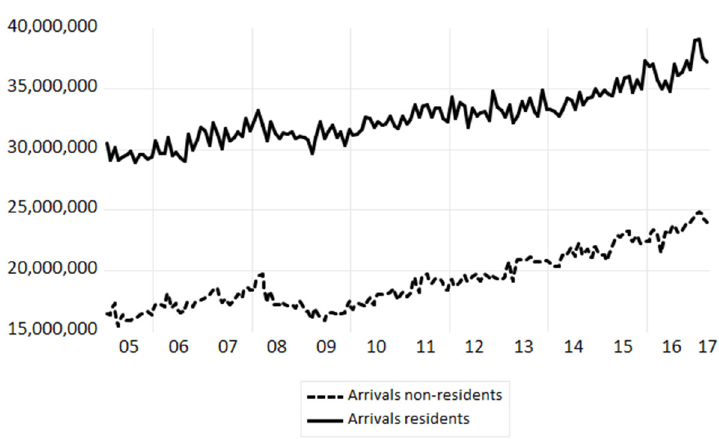
Figure 1. Arrivals of residents (solid line) and non-residents (dashed line) for the EU-27 (seasonally adjusted by the multiplicative ratio to moving average method). Source: Eurostat and own illustration.